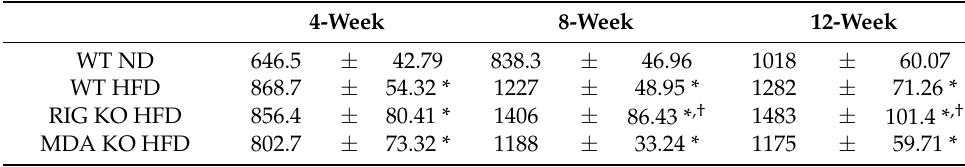
Figure 3. RIG-I deficiency aggravates high-fat diet-induced insulin resistance. ( A – C ) Intraperitoneal glucose tolerance tests were performed. Glucose solutions (2 g/kg) were administered via intraperi- toneal injection after a 4-h fast. Blood glucose levels were measured at 0, 15, 30, 60, 90, and 120 min after the glucose challenge at 4, 8, and 12 weeks on diet. ( D , E ) The levels of fasting serum insulin and serum homeostasis model assessment of insulin resistance (HOMA-IR) at 12 weeks. The values represent the means ± SEM ( n = 5). ( A – C ) * p < 0.05 compared with WT ND mice. † p < 0.05 compared with WT HFD mice. ( D , E ) * p < 0.05. Table 1. Area under the curve (AUC) of intraperitoneal glucose tolerance